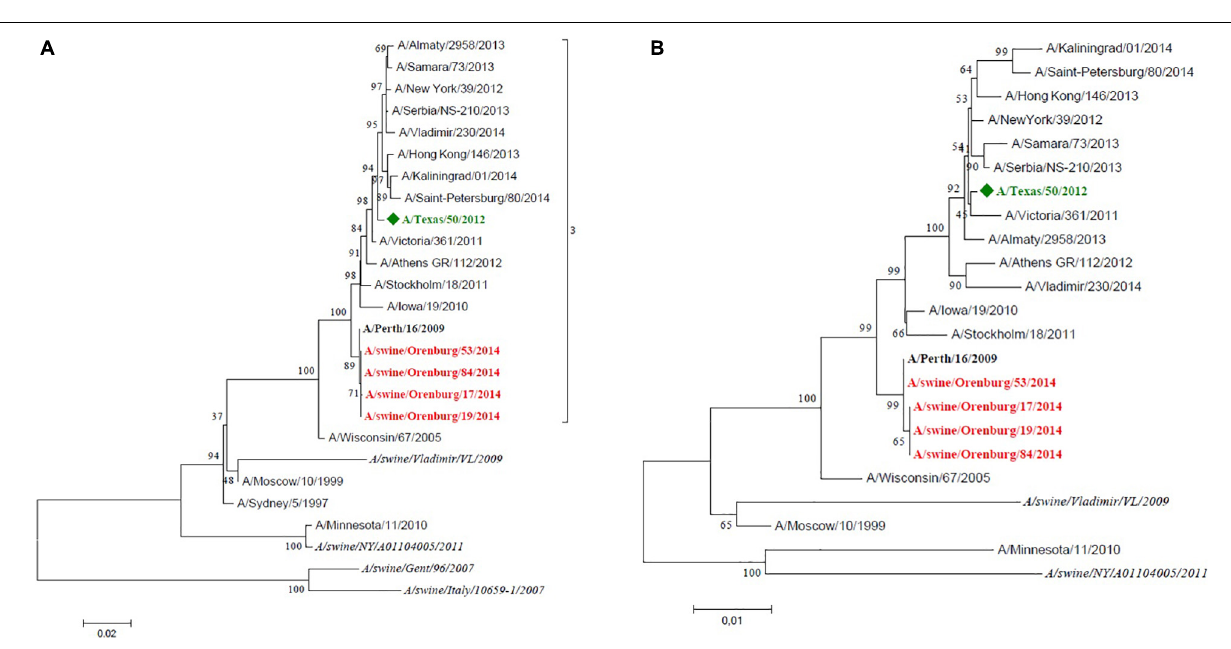
FIGURE 3 | Maximum likelihood tree for swine influenza A HA (A) and NA (B) of H3N2 isolated in 2014. The vaccine strain at that time is shown in green. Reference strains are in black bold. Swine strains from this study are shown in